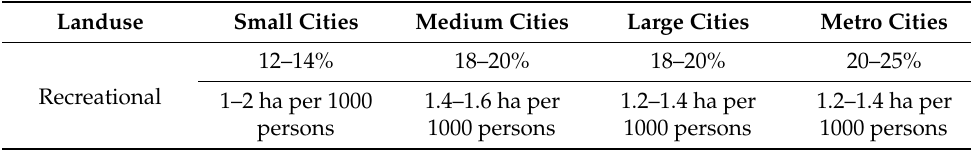
Table 5. Recreational Land Use Structure for Developable Area in Urban Centers.